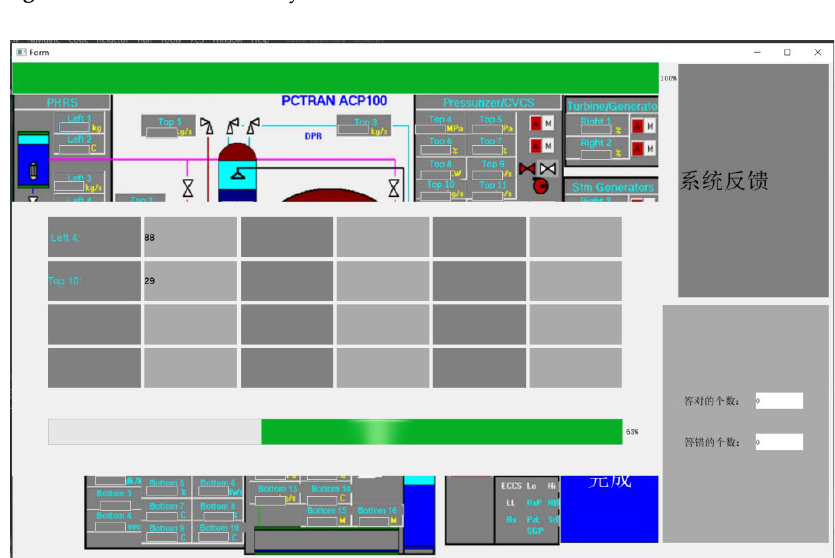
Figure 1. Interface of Memory Task.